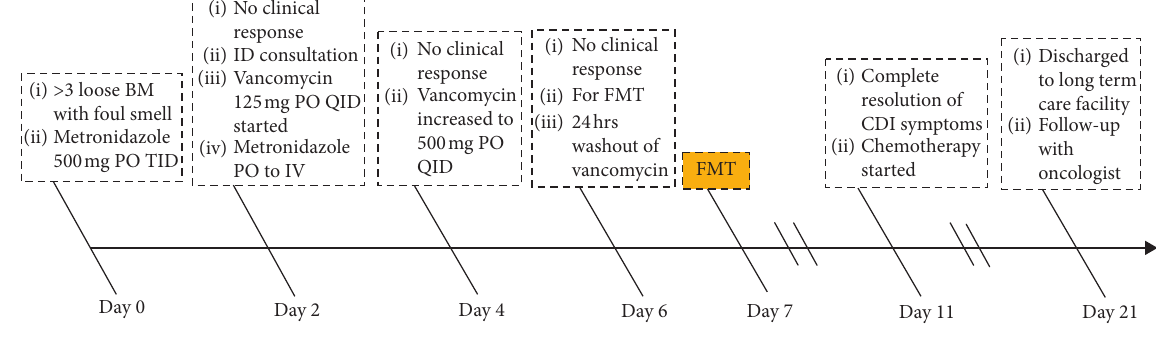
Figure 1: Patient hospital course